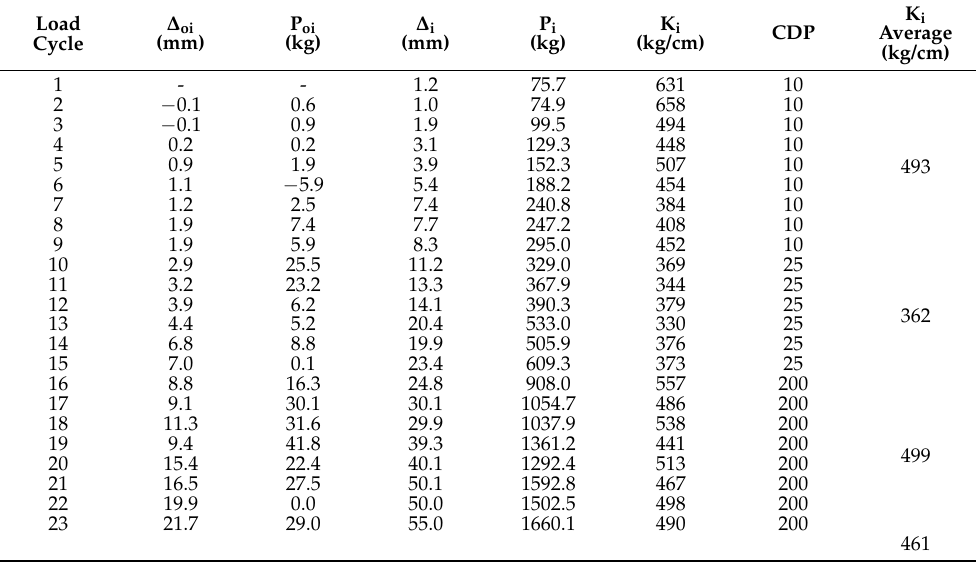
Table 5. Record of the shifting and loads on the experiment